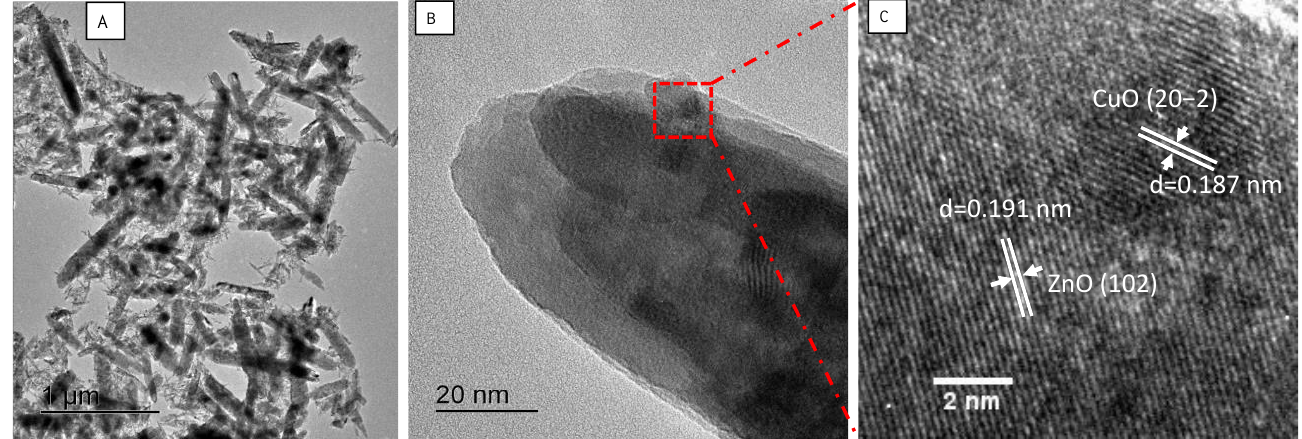
Figure 3. TEM images of (rGO-ZnO)/CuO ( A , B ) and HRTEM ( C ).